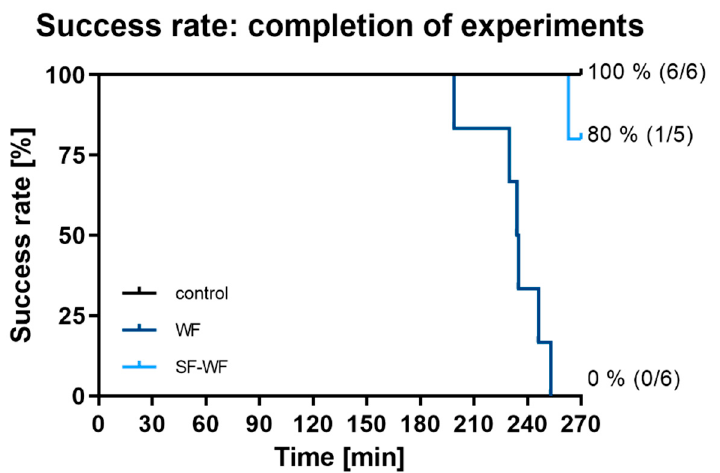
Figure 1. Influence of welding fume instillation on IPLs. Success rates of groups over 270 min of experiment. Control and WF n = 6, SF-WF n = 5.